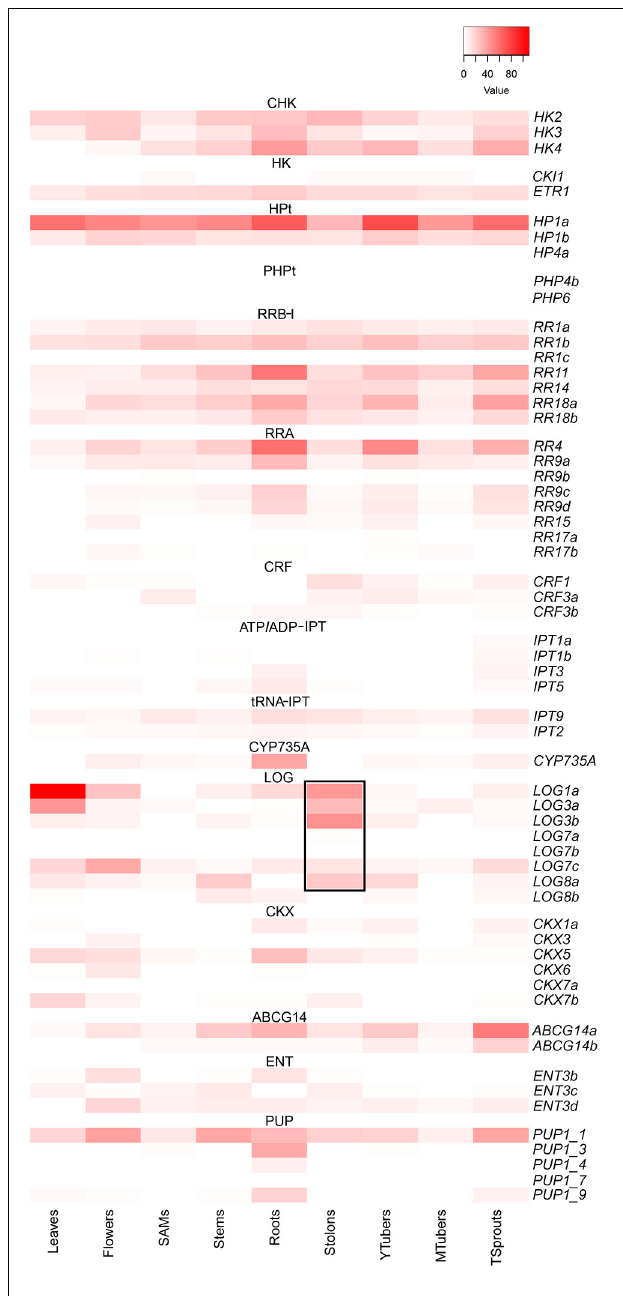
FIGURE 1 | Expression pattern of cytokinin system genes of potato generated with the use of Heatmapper service (http://www.heatmapper.ca/expression/) (Babicki et al., 2016). The LOG gene expression pattern in the stolon is framed. SAMs, shoot apical meristems; YTubers and MTubers, young and mature tubers, respectively; TSprouts, tuber